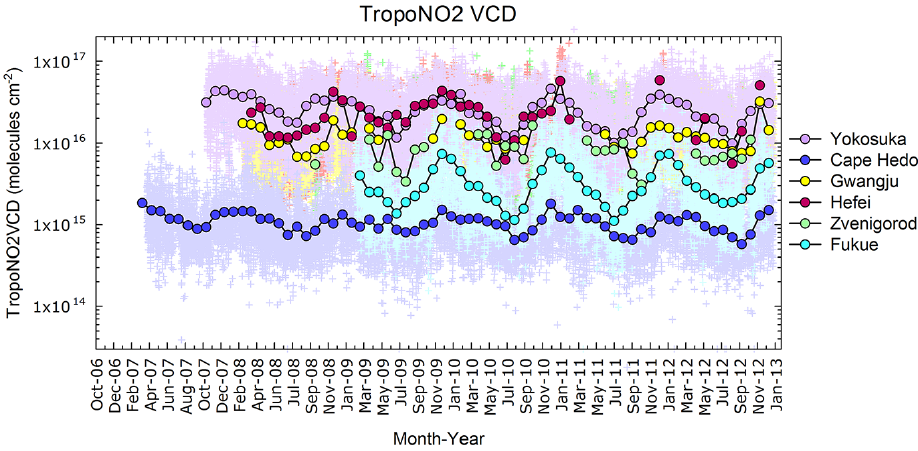
Figure 6. Time series of all individual observations of TropoNO2VCD (plus signs, 30min time resolution) and their monthly averages